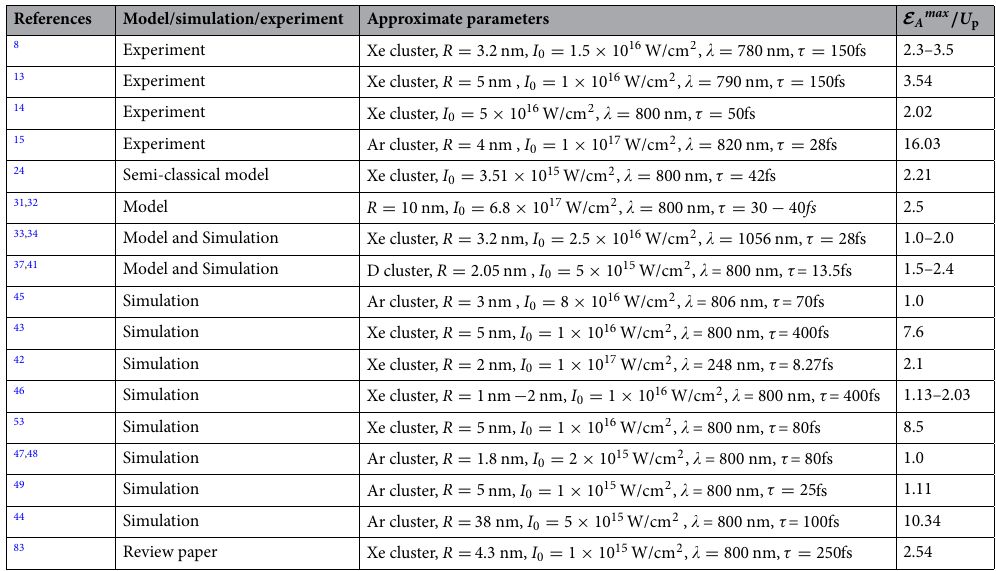
Table 1. Approximate value of maximum average absorbed energy E U p ) of an electron from traditional laser-cluster interaction in various published works. These are calculated from the available data/graphs. In most cases E